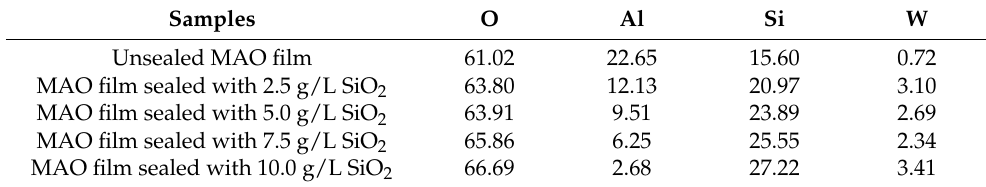
Table 3. EDS Analysis (at%) of